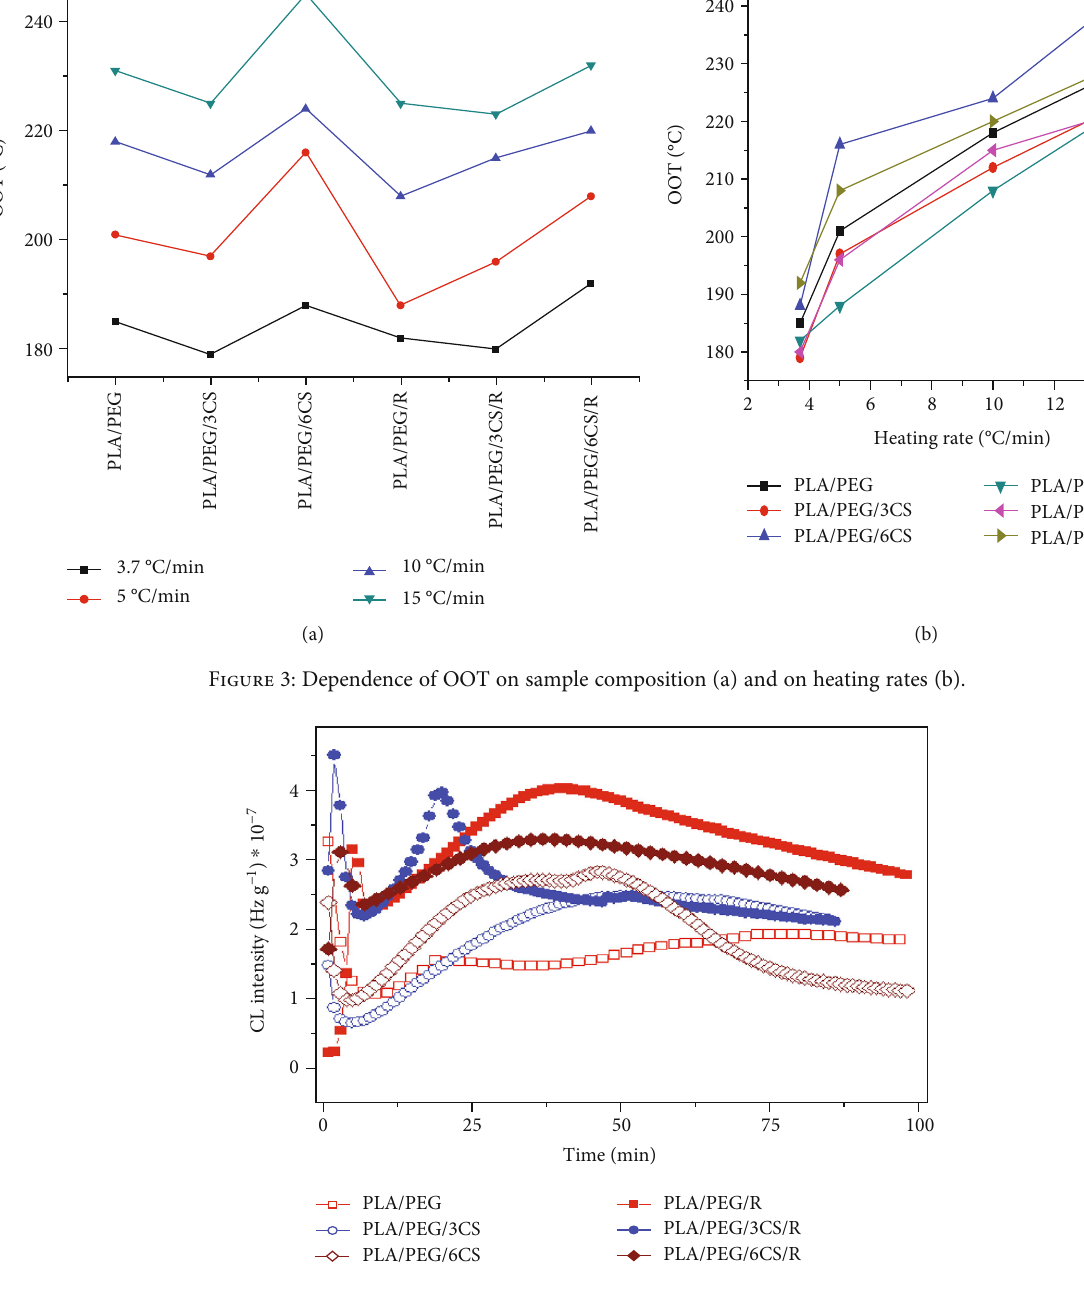
Figure 4: CL spectra for plasticized PLA samples of various compositions recorded in isothermal conditions at 170 °